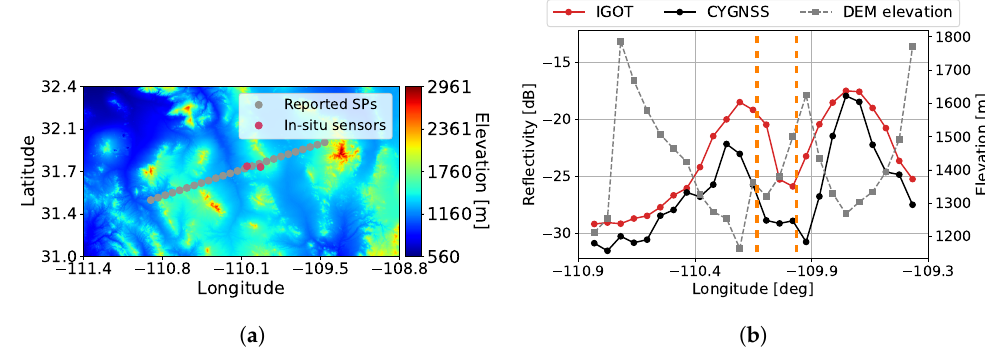
Figure 6. WG track 1 : ( a ) Track elevation map; ( b ) Peak reflectivity. The SoilSCAPE sites are between the orange vertical